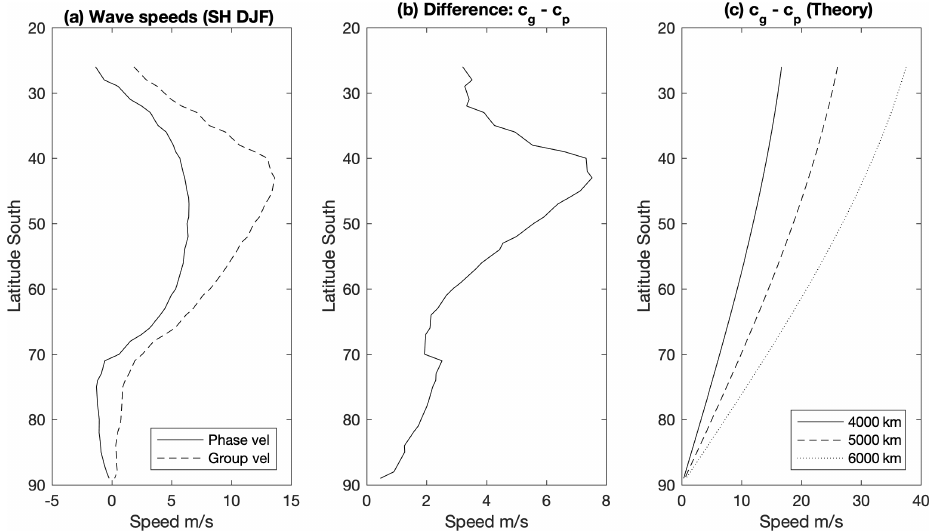
Figure 9. Phase and group velocities (a) and their difference (b) derived from the Z 500 correlation analysis. Predicted differences using barotropic theory for some example zonal wavelengths are shown in panel (c)